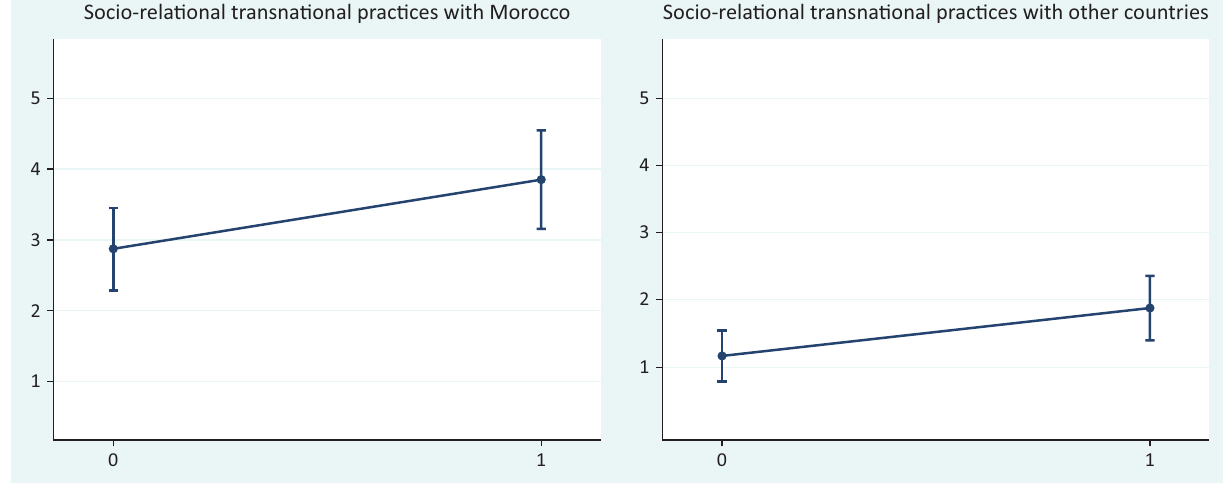
Figure 1. Predicted counts of socio-relational transnational practices with Morocco and third countries (Y-axis) for domes- tic (0) and transnational (1) entrepreneurs (X-axis) from models in Table